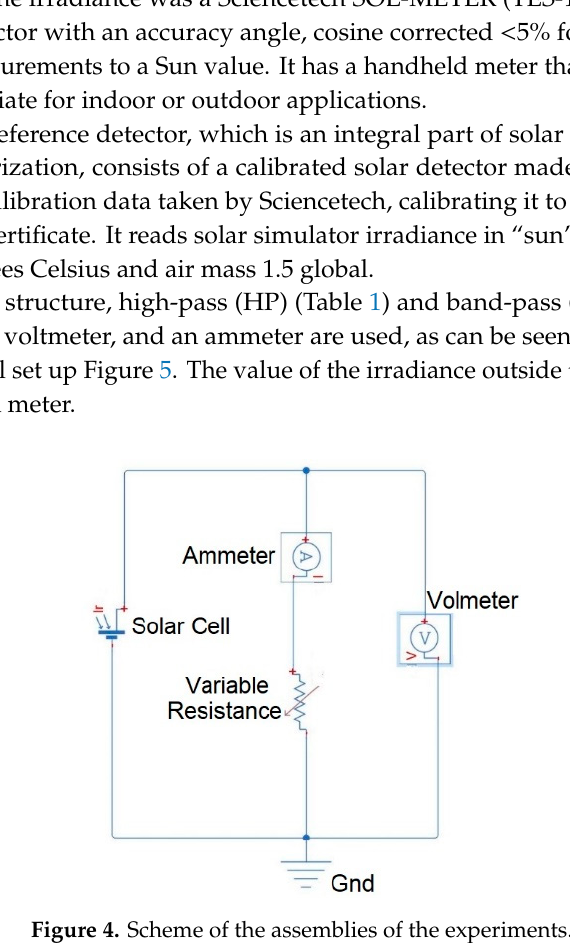
Figure 4. Scheme of the assemblies of the experiments.